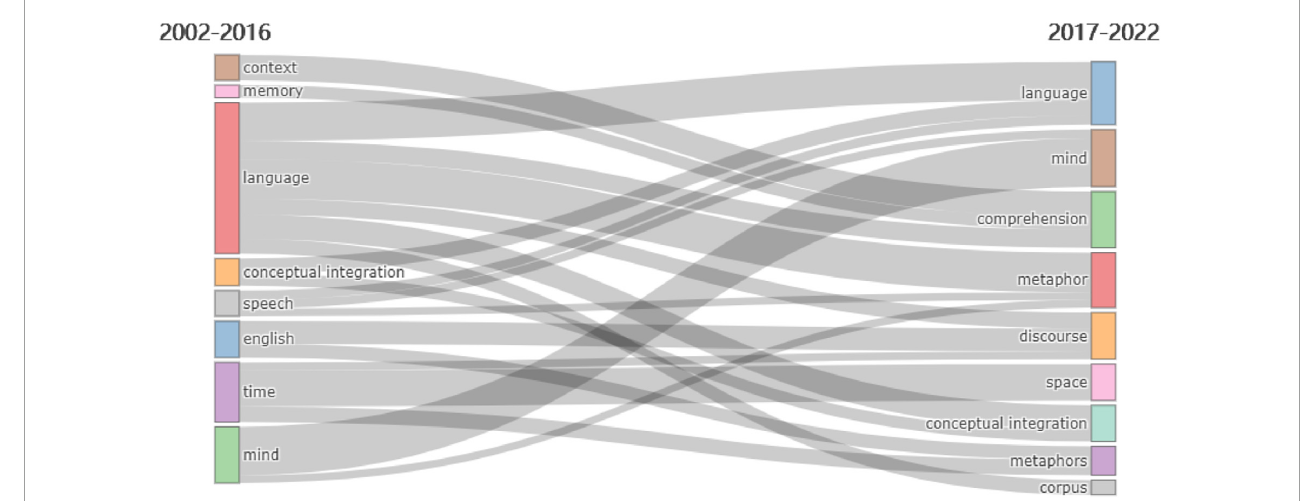
FIGURE13 Thematic evolution. Each hue represents a distinct subject, and the size of the rectangle means the depth of study.